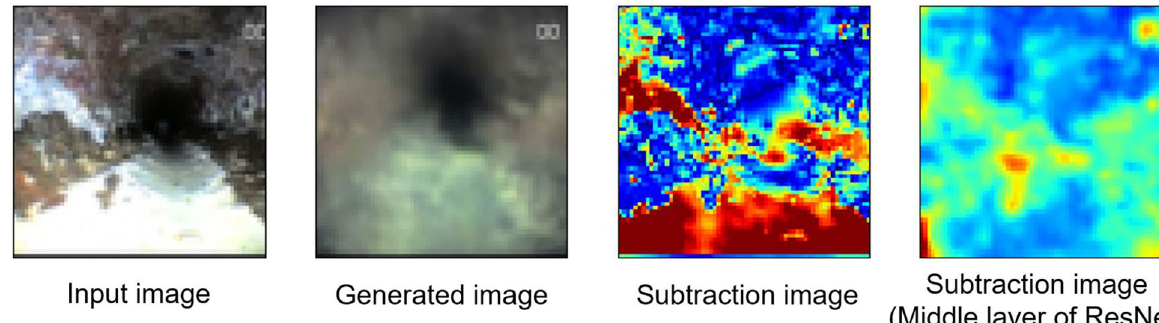
Fig. 14 Experimental results of rust anormaly cast iron pipe